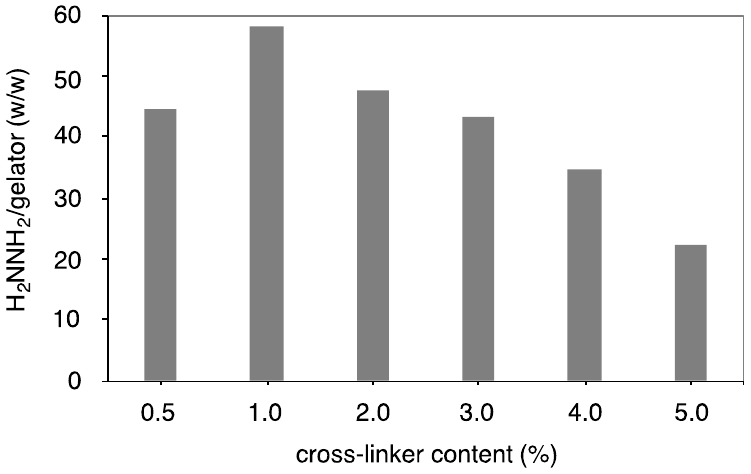
Figure 3 . Effect of cross-linker content on saturated amount of anhydrous hydrazine absorbed by CPAM.